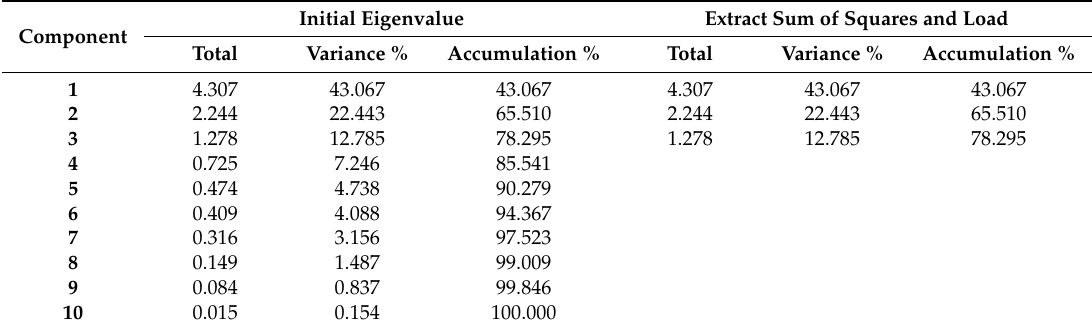
Table 2. The extracted principal components of water quality indexes.